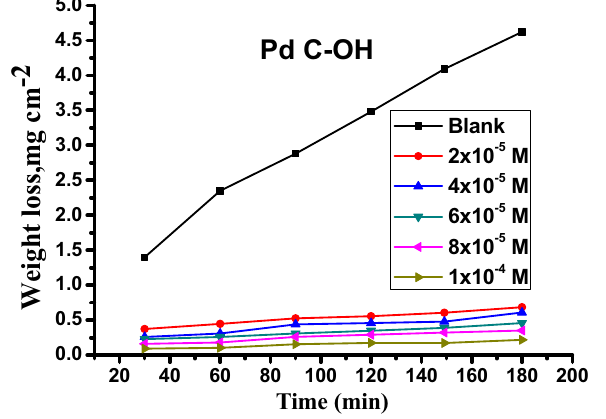
Figure 3. Weight loss-time curve for dissolution of carbon steel in 1 M HCl without and with various concentrations of PdC-OH + KI at 25